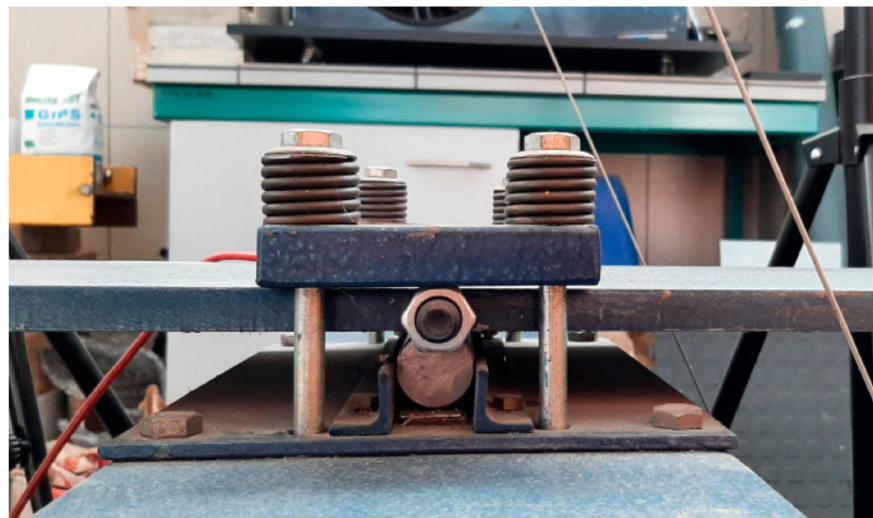
Figure 16. Bearing’s arrangement.